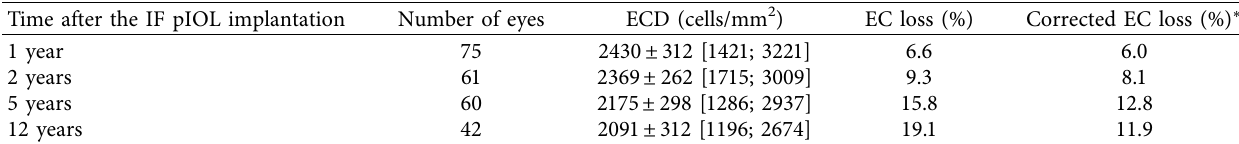
Figure 3: Mean endothelial cell density (ECD, cells/mm 2 ) from the preoperative status to 12-year postoperative status in eyes implanted with iris-fixated phakic intraocular lenses. Table 6: Endothelial cell density after the IF pIOL